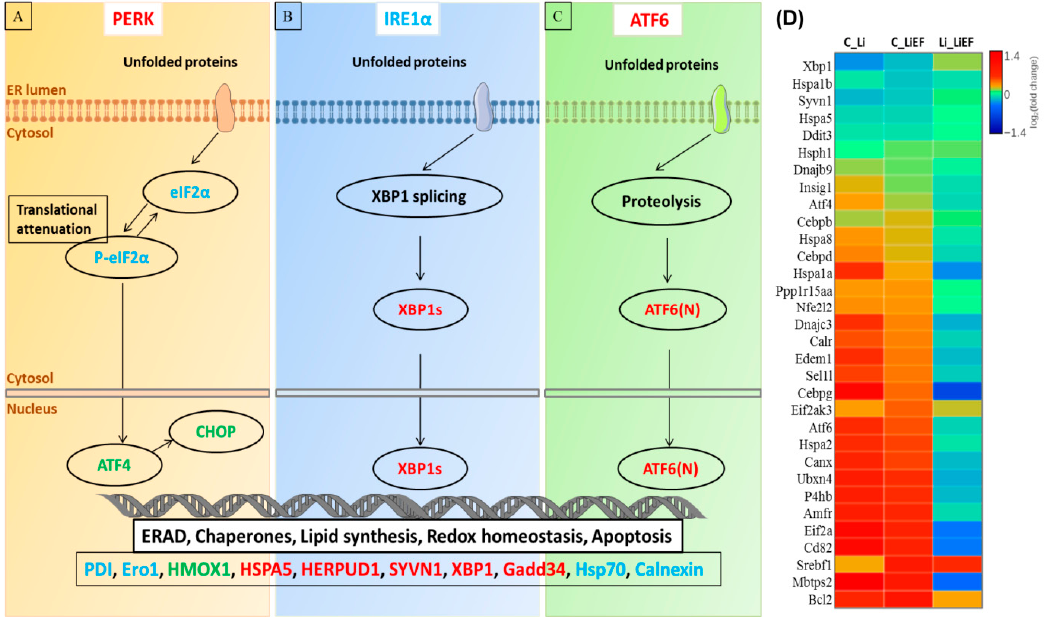
Figure 6. Unfolded protein response (UPR) pathway. ( A – C ) Schematic representation of UPR pathway. The UPR pathway is mediated by three different branches: ( A ) PERK-eIF2 α -ATF4-CHOP branch, ( B ) IRE1-XBP1 branch, and ( C ) ATF6 branch. These three branches are indicated by different colored font. Markers investigated in this study are highlighted in red (RNA), blue (protein) and green (both RNA and protein). ( D ) Heat map of Differentially Expressed Genes (DEGs) involved in UPR pathway based on log 2 (fold change) obtained from RNA-Sequencing. Heat map is generated using a graphical user interface Plotly.